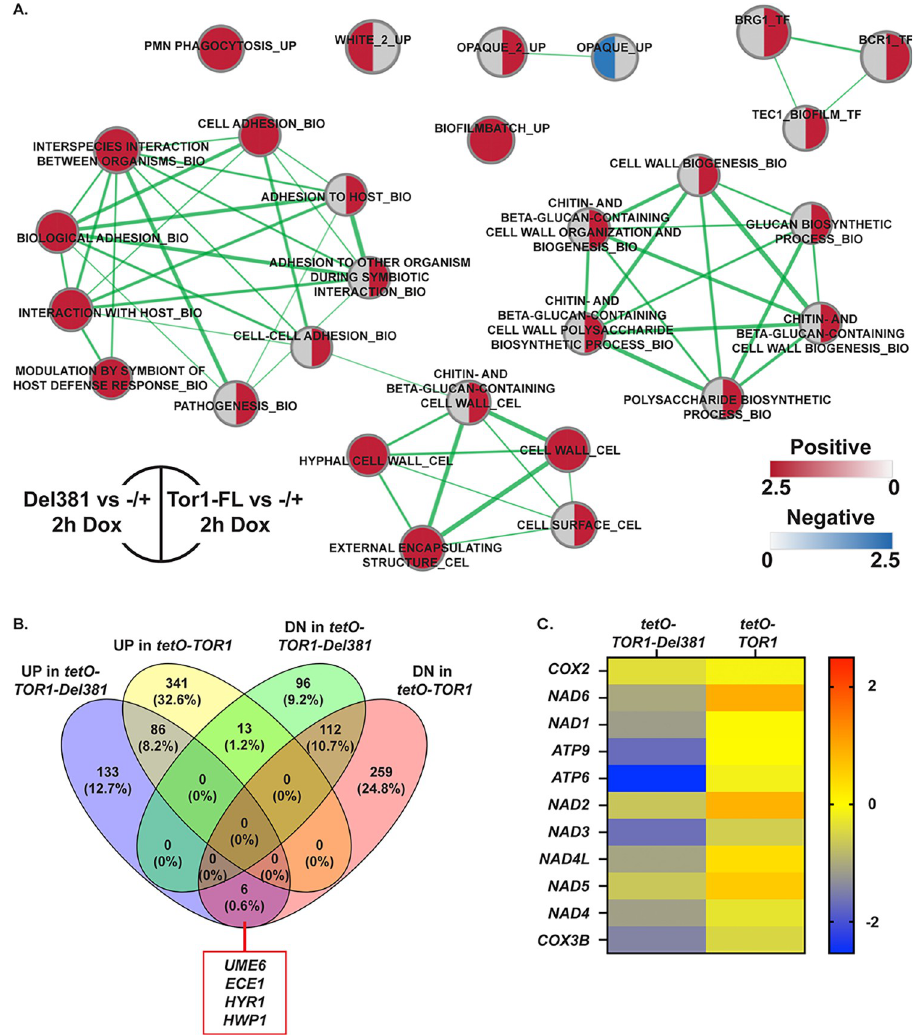
Fig 12. Comparison of gene set expression changes during repression of TOR1 and TOR1-Del381 in FL and Del381 cells exposed to doxycycline. A. Enrichment map showing the major categories of genes identified by Gene Set Enrichment Analysis (GSEA) in the transcript profiles of tor1/tetO-TOR1-Del381 cells (JKC1441, left side) and tor1/tetO-TOR1 cells (JKC1549, right side) compared to heterozygous tor1/TOR1 cells (-/+, JKC1347) following tetO repression in YPD with doxycycline for 2 h. Nodes represent gene sets (FDR q < 0.1) where color intensity reflects the Normalized Enrichment Score (NES) and node size reflects the number of enriched genes. Width of connecting lines (edges) indicates the degree of overlap between categories. Grey indicates the category was not significant under the experimental condition. B. Comparison of gene expression changes ( � 2-fold up and down) in tor1/tetO-TOR1-Del381 (JKC1441) and tor1/tetO-TOR1 (JKC1549) cells exposed to doxycycline for 8 h. Six genes induced in tor1/ tetO-TOR1-Del381 cells were suppressed in tor1/tetO-TOR1 cells, including UME6 , ECE1 , HYR1 and HWP1 . C. Heatmap showing expression of genes that encode Complex I of the mitochondrial electron transport chain in tor1/ tetO-TOR1-Del381 (JKC1441) relative to the heterozygote tor1/TOR1 (column 1) and in tor1/tetO-TOR1 (JKC1549) relative to the heterozygote tor1/TOR1 (column 2). Expression values are Log2 values relative to tor1/TOR1 (JKC1347). specific genes like UME6 , ECE1 and HWP1 (Fig 12B). Dysregulation of hyphal-specific genes may partially explain Del381 cells’ conditional hyperfilamentous phenotype (Fig 9A). Phenotypically, Del381 cells were strongly hypersensitive to cell wall stress (Fig 7A,B) with only minor defects in cell wall integrity signaling (Fig 7C). GSEA analysis found that compared with FL cells, transcription of their cell wall biosynthetic genes was decreased during